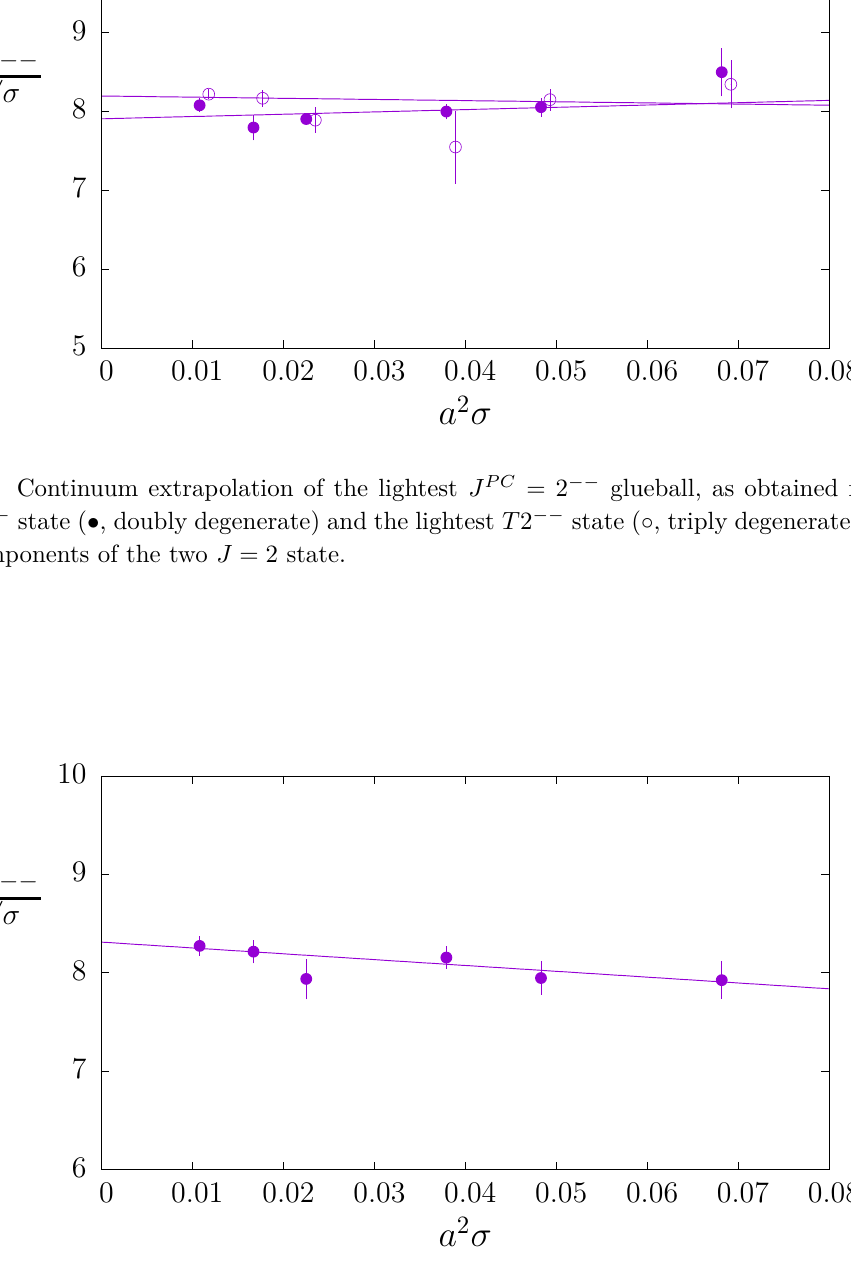
Figure 24 . Continuum extrapolation of the mass of the lightest J PC = 1 −− glueball state corre- sponding to the (triply degenerate) T 1 + − ground